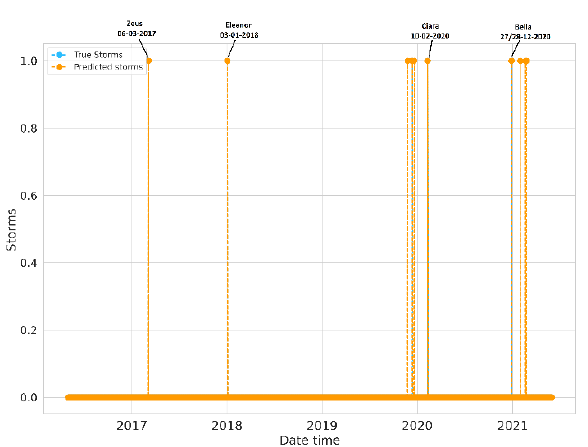
Figure 5 . Storm prediction results from the SVM model.